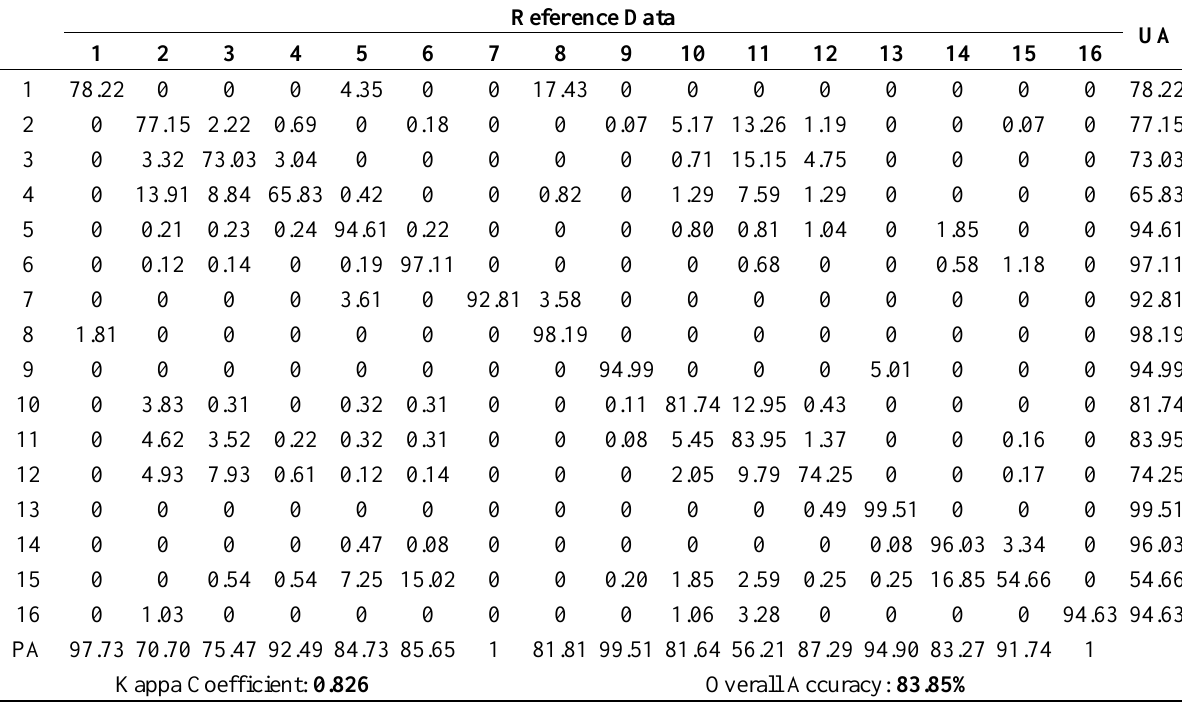
Table 6. The classification error matrix for data set IPS of 16 classes (in